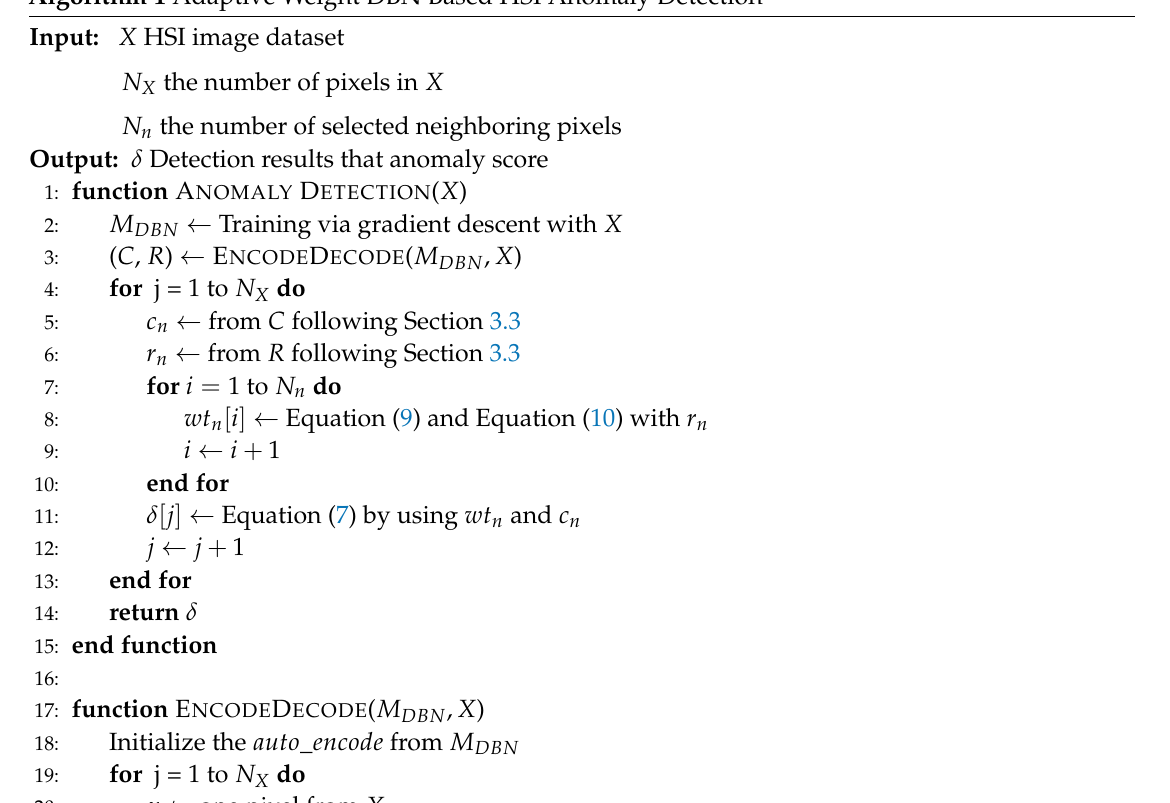
Figure 2. The data flow of the proposed algorithm, Window height and Window width stand for the height and width of the local image window, respectively. B stands for spectral band number. L c stands for the length of the code. δ stands for the anomaly score. Algorithm 1 Adaptive Weight DBN Based HSI Anomaly